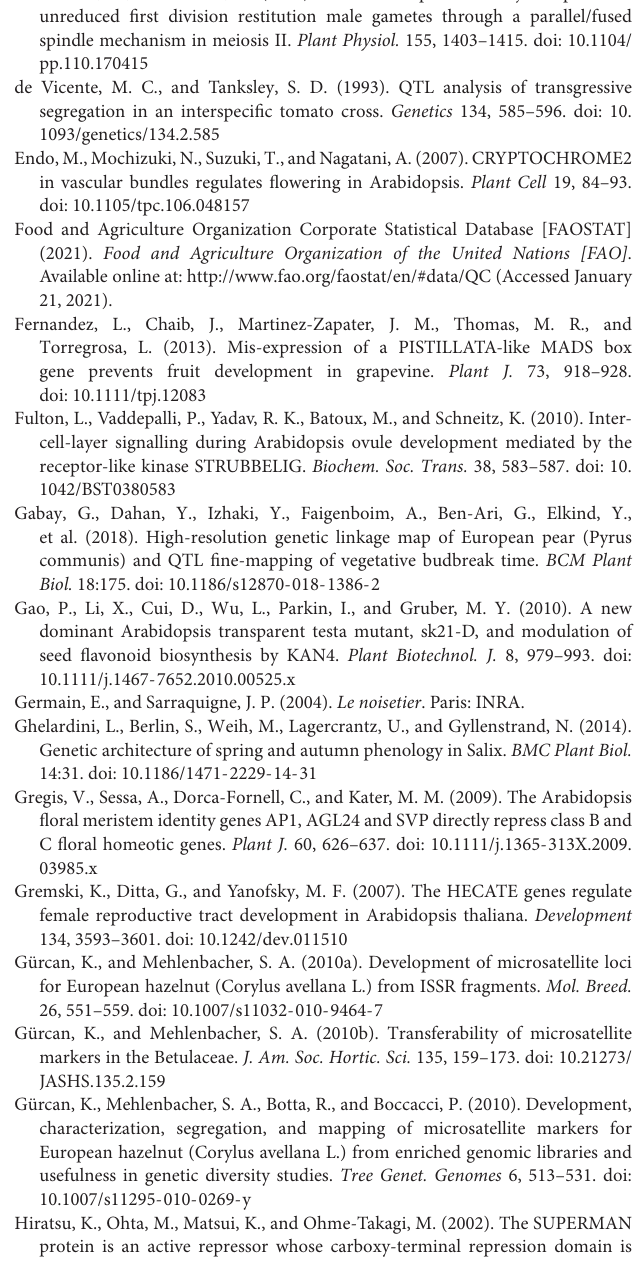
segregants recorded over four